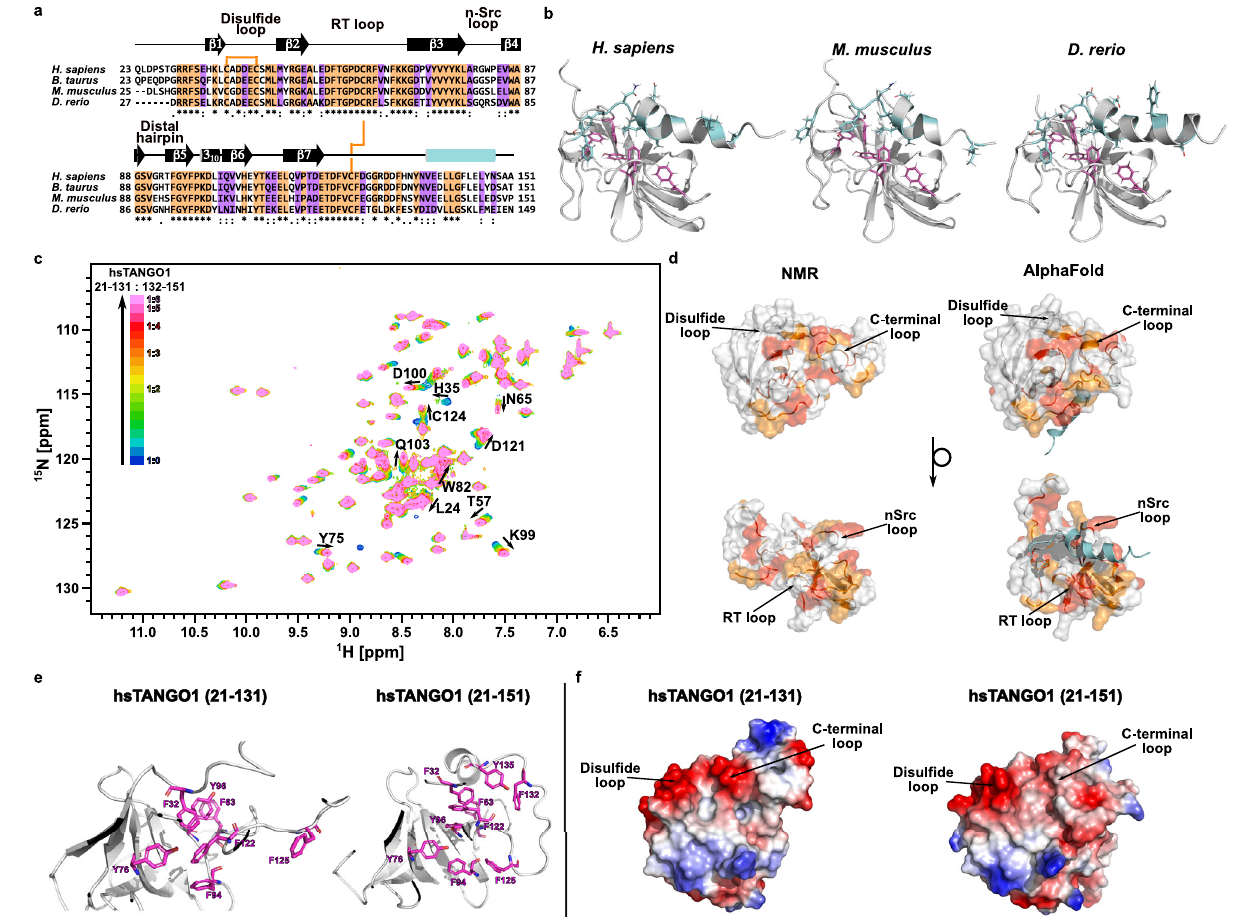
Fig. 3 | The predicted C-terminal helix is conserved and binds to TANGO1 ’ s cargo-recognition domain. a Multiple sequence alignment of the cargo- recognition domain of TANGO1 from different vertebrate organisms. Conserved and semi-conserved residues are highlighted in orange and purple, respectively. Conserved disul fi de bridges are indicated by orange lines. b TANGO1 ’ s cargo- recognition domain displays a C-terminal helix that is conserved throughout ver- tebrate organisms, e.g., human, mouse, and zebra fi sh (AF-Q5JRA6-F1 [https:// alphafold.ebi.ac.uk/entry/Q5JRA6], AF-Q8BI84-F1 [https://alphafold.ebi.ac.uk/ entry/Q8BI84], and AF-F1R5N2-F1 [https://alphafold.ebi.ac.uk/entry/F1R5N2], respectively. Accessed via https://alphafold.ebi.ac.uk/). Conserved aromatic resi- dues within the domain are shown as magenta, conserved residues corresponding to the region of the synthetic peptide as cyan sticks. c 2D 1 H 15 N HSQC titration spectra. Labeled residues were used for subsequent determination of K D and k off